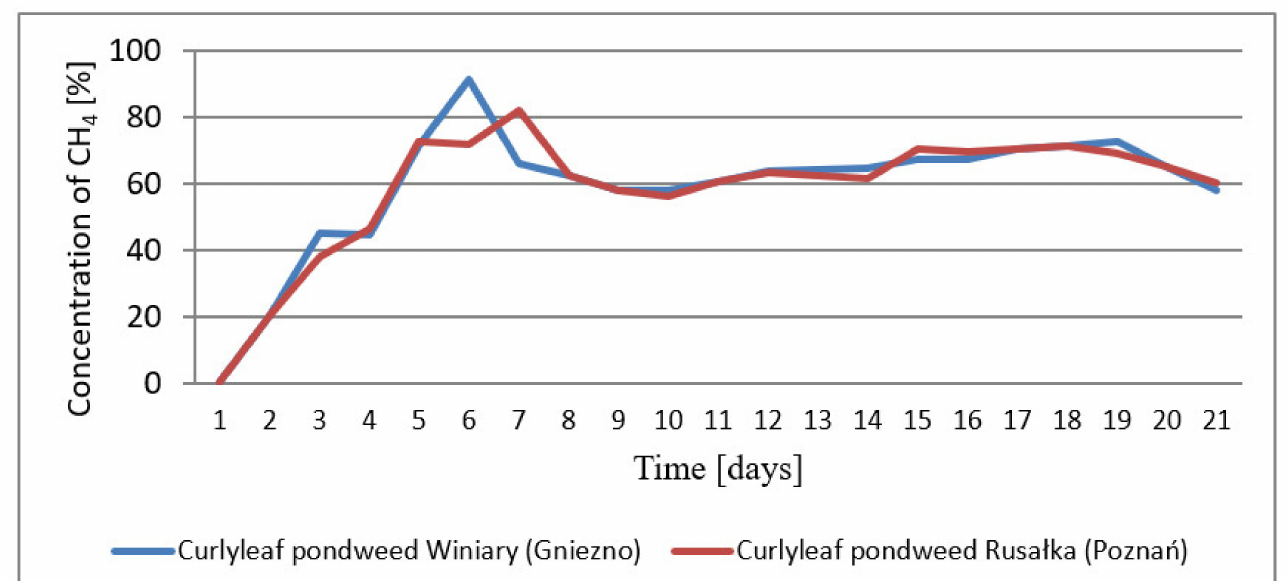
Figure 6. Graph of biomethane concentration in